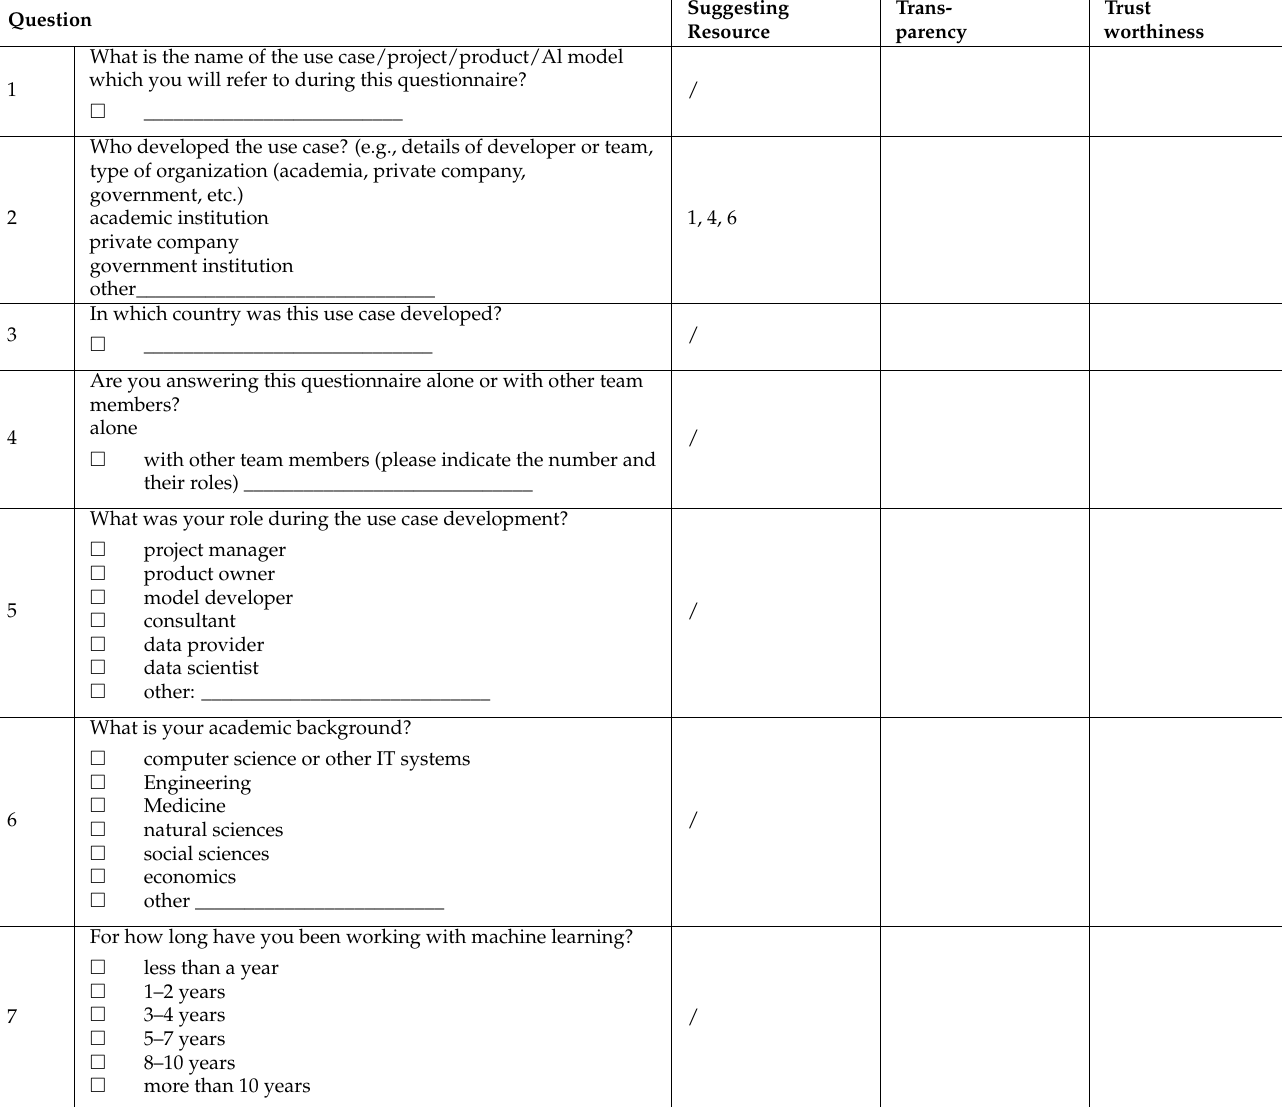
Table A2. Full questionnaire for transparent model reporting. The reporting structured questionnaire contains 79 semi-open questions within the dimensions: (0) Information about the participant, (1) Intended use of the model, (2) Implemented ML technology, (3) Training data information, (4) Legal aspects and Ethical considerations, (5) ML model evaluation and metrics, and (6) Caveats and recommendations. The questions allowed a single answer, unless specified as ‘Multiple answers possible’. The column ‘Suggesting resource’ lists the references for each question that motivated their selection into the questionnaire. The numbers link to references of guidelines and considerations listed in the table above (Table A1). Note that the resources may not be exhaustive. Crosses in the columns ‘Transparency’ and ‘Trustworthiness’ mark whether the question was included for scoring the degree of transparency or